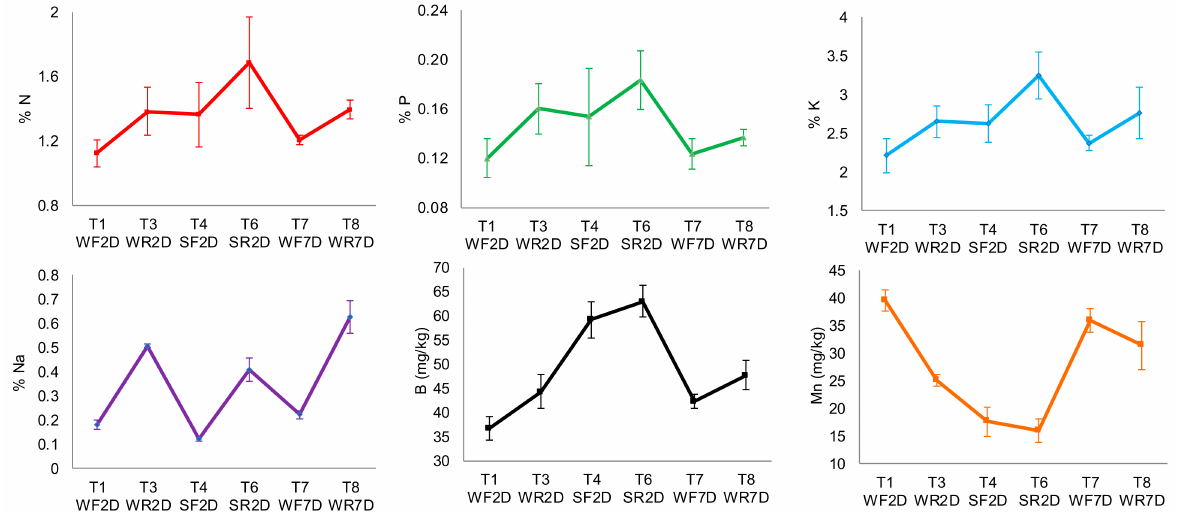
Figure 10. Accumulated elements in plant tissues for different irrigation treatments. See Table 2 for treatment